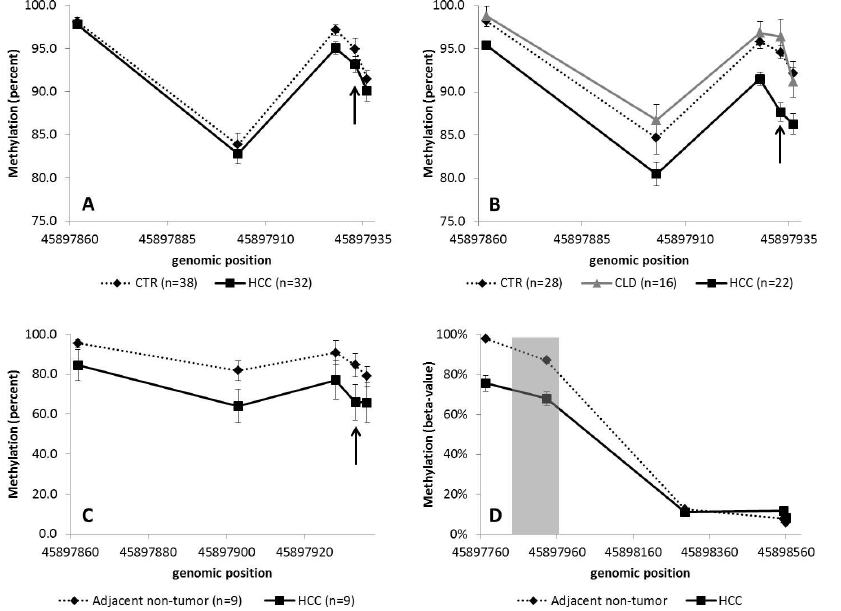
Fig 3. FBLN1 methylation in cfDNA. Cases from France (A) and Thailand(B), in tissue (C) (the arrows show the CpG-site analysedin TCGA data) and in TCGA data (D) (the grey area represents the area analyzedby massively parallelsequencing in this study). CTR: controls, HCC: hepatocellularcarcinoma patients and CLD: chronicliver diseases. The error bars represent standard error of mean.